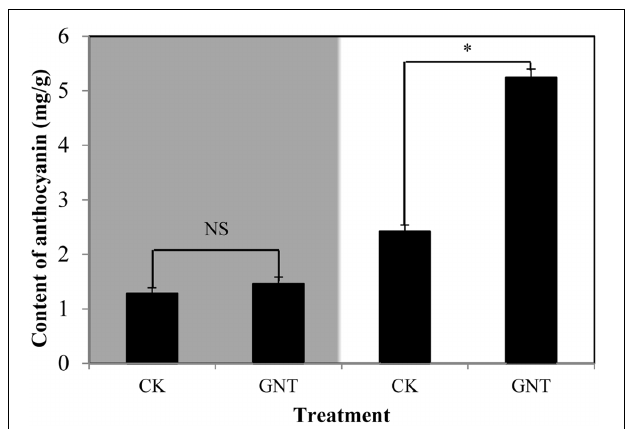
FIGURE 4 | Anthocyanin levels of red cabbage under GNT treatment in dark and light conditions. The colored section is dark condition and bright section is light condition. The data are mean ± SD ( n = 3) and the symbol ∗ represents significant difference with CK and treatments at P = 0.05 level while NS means not